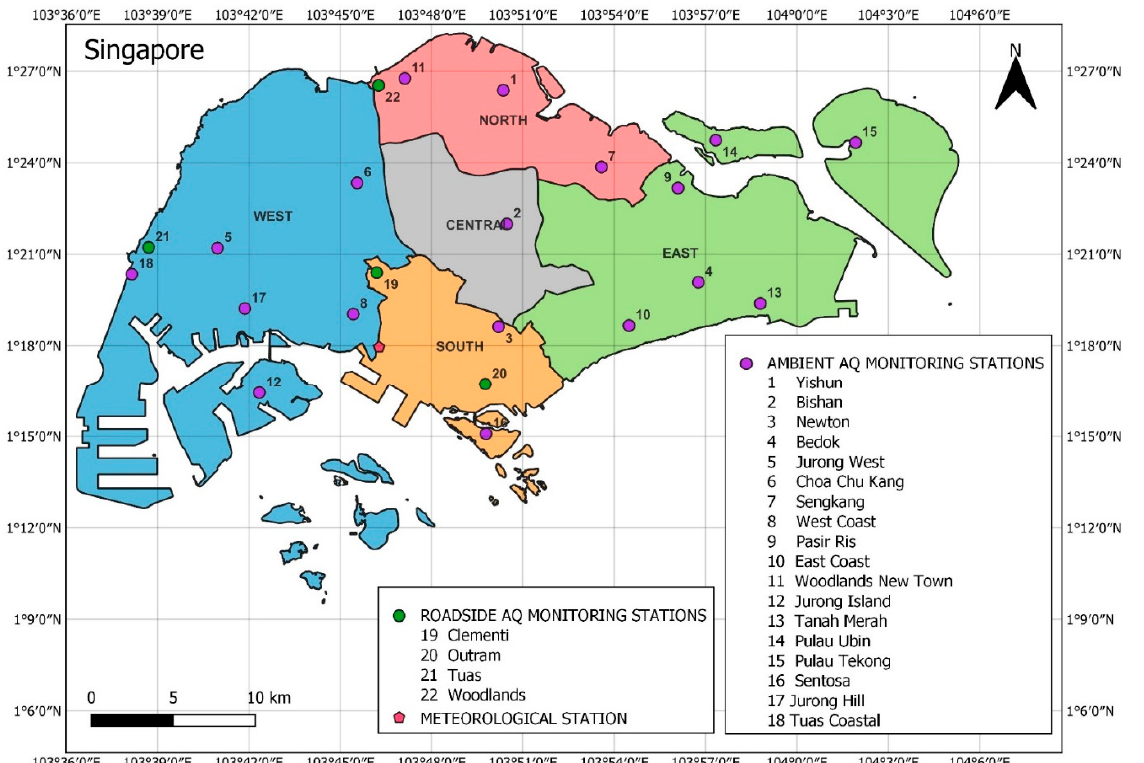
Figure 1. Locations of 4 air quality (AQ) monitoring stations across the four districts and a meteorological station in Brunei-Muara district in Brunei Darussalam.